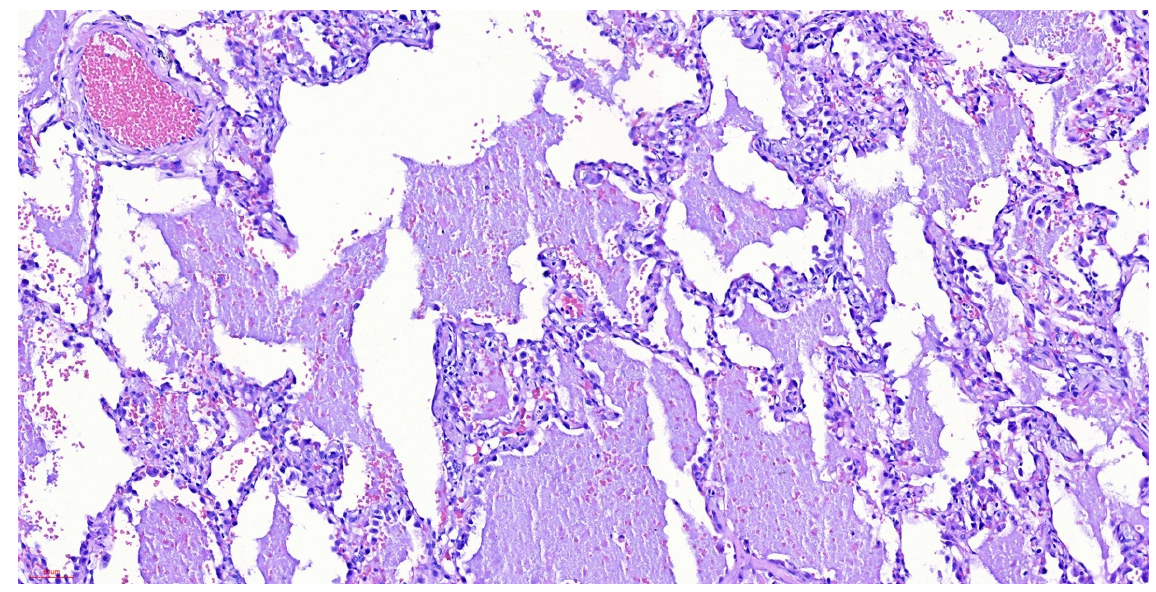
Figure 2. Wedge lung biopsy with hematoxylin-eosin stain, demonstrating pulmonary parenchyma with emphysematous and reactive epithelial changes, pneumocyte hyperplasia, and dilated alveoli occupied by eosinophilic material, with a low-grade hemorrhage and occasional histiocytes and anthracosis. Negative for malignancy, changes related to alveolar proteinosis.